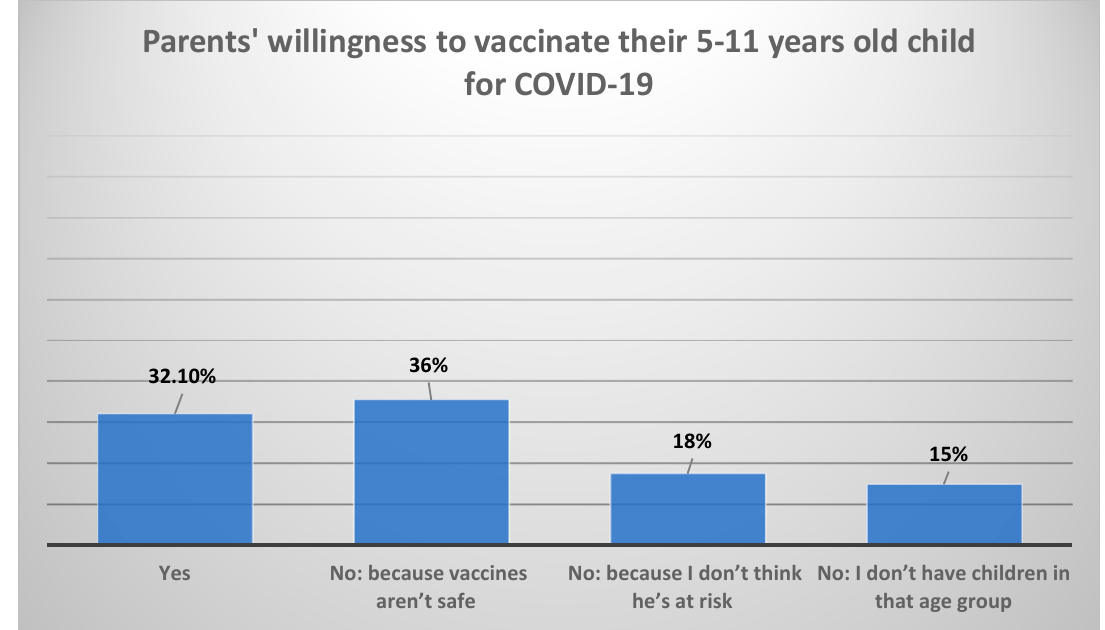
Figure 4. Parents’ willingness and reasons to avoid giving their children (5–11 years of age) the COVID-19 vaccine.